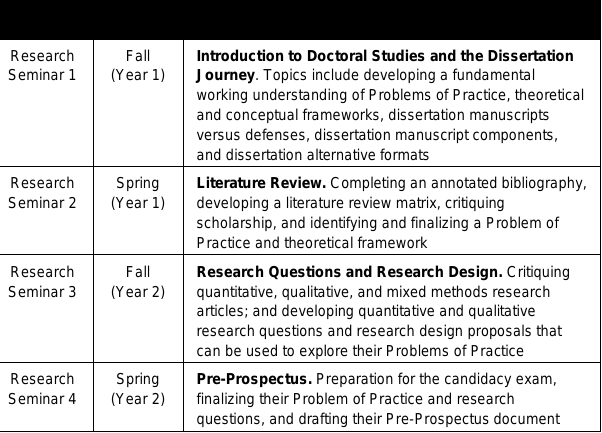
Research Seminar 1